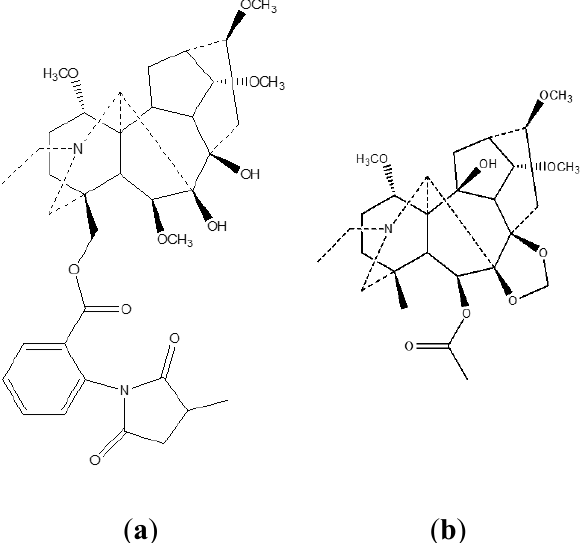
Figure 1. ( a ) Methyllycaconitine (MLA) (MSAL-type alkaloid); ( b ) deltaline (non MSAL-type alkaloid). Structure of a MSAL-type alkaloid methyllycaconitine (MLA) and a non MSAL-type alkaloid